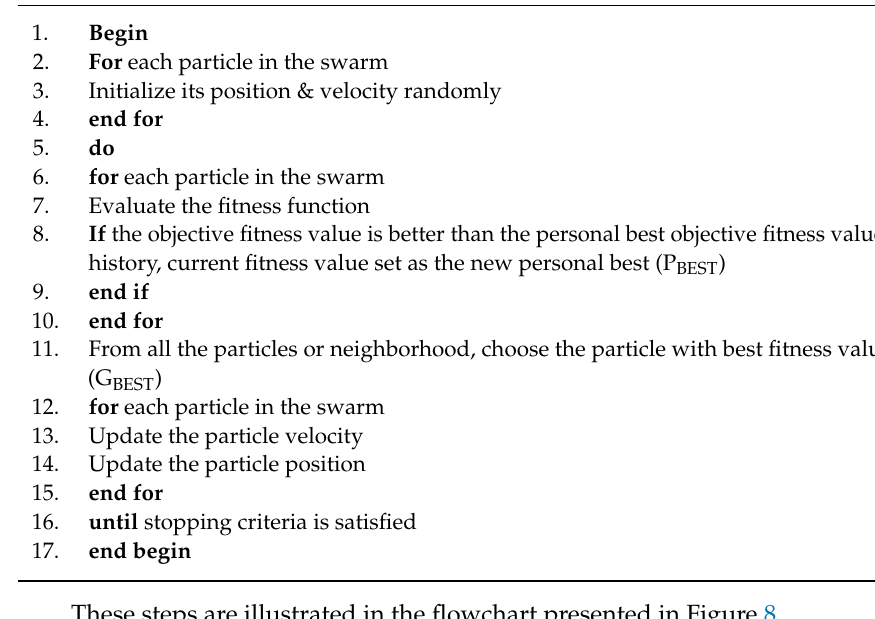
Algorithm 3: Pseudo code of PSO